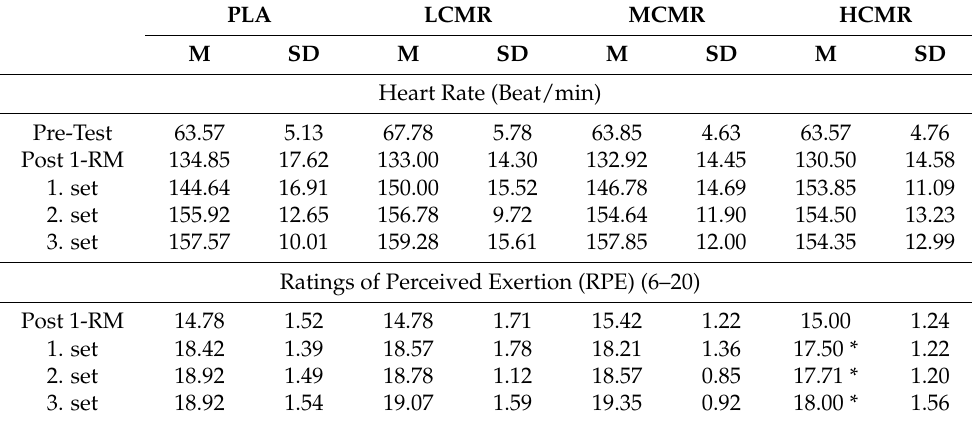
Table 1. Heart rate and RPE values.